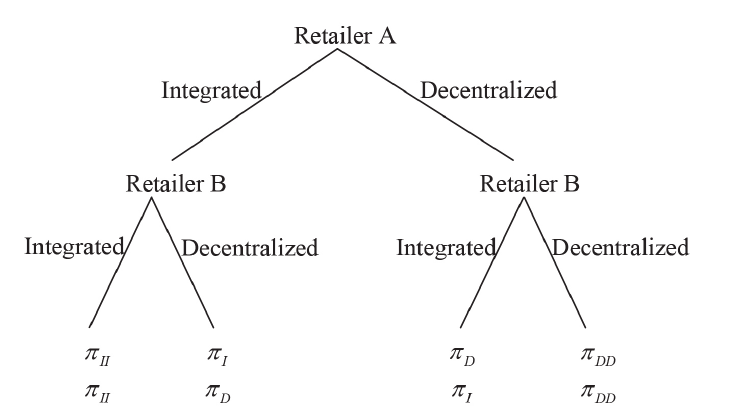
<Figure 1> The Sequential-Channel-Choice